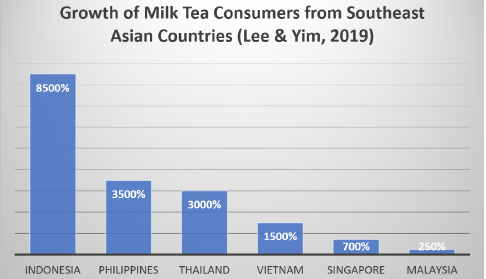
Figure 1. Percentage growth of milk tea consumers from Southeast Asian Countries. Adapted from